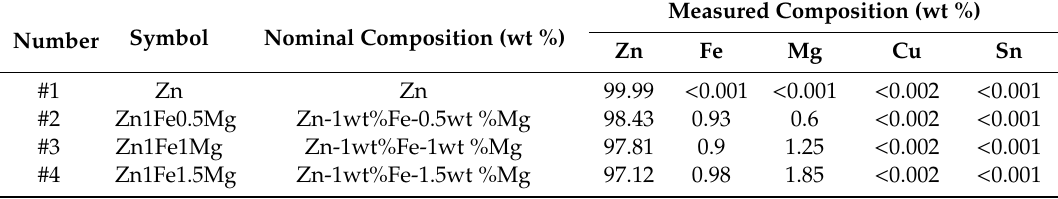
Table 1. The actual components of alloys measured by Inductively Coupled Plasma Optical Emission Spectrometry